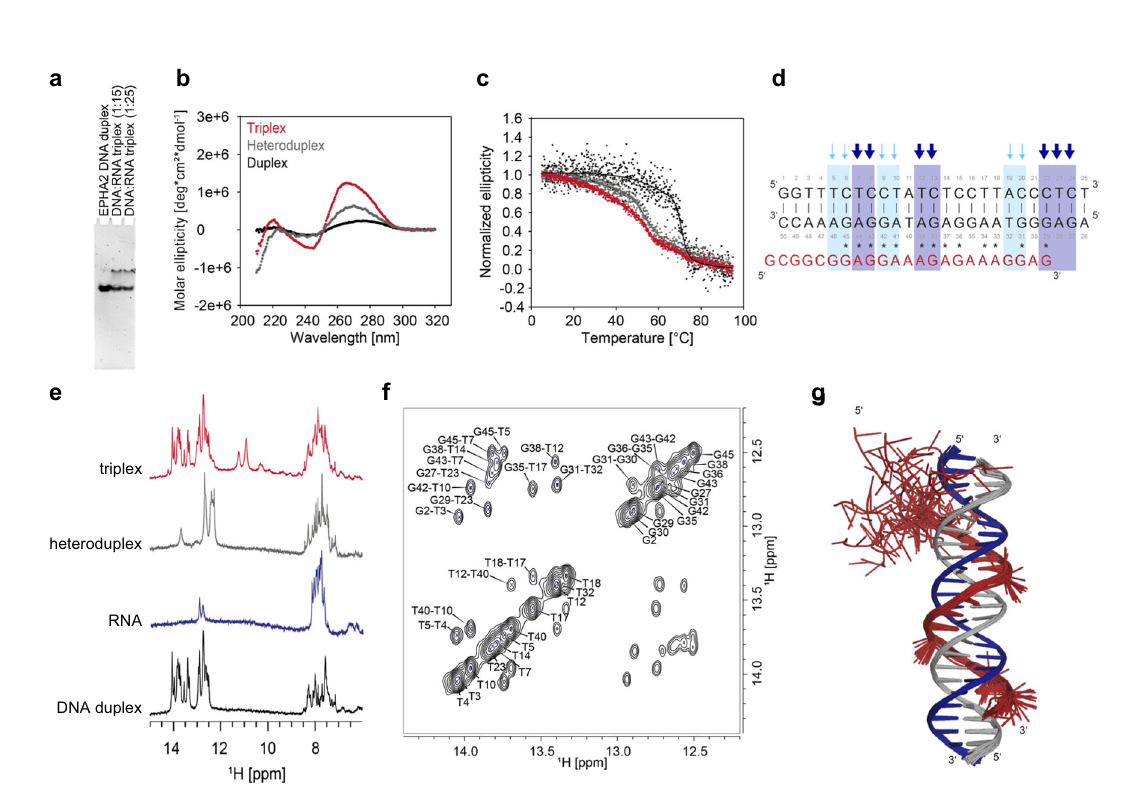
Fig. 2 | HIF1 α -AS1 potentially forms DNA:DNA:RNA triplexes. a Overview of the identi fi cation of HIF1 α -AS1 triplex forming regions (TFR) and their DNA triplex target sites (TTS) with triplex domain fi nder (TDF). HIF1 α -AS1 pre-RNA and ATAC- Seq of HUVECstreatedwith orwithout LNAGapmeRsagainst HIF1 α -AS1 wereused as input for TDF. RIP and LNA GapmeRs were used to validate the fi ndings of TDF. b All three TFRs of HIF1 α -AS1 have a signi fi cantly higher number of DNA triplex targetregions(bluedots)thantherandombackground(boxplotsingray).Boxplot visualizes the median, fi rst and third quartiles. The whiskers present the 1.5 inter- quartile range. External gray dots represent outliers. Numbers in brackets are positions of the individual TFR within HIF1 α -AS1 pre-RNA. Analyzed with TDF, n=200randomizations. c CircosplotshowingthelocalizationoftheindividualTFR within HIF1 α -AS1 pre-RNAanditsinteractionwiththechromosomalTTS. d Overlap of TTS of the individual TFRs of HIF1 α -AS1 . e Identi fi cation of RNase H-resistant TFRs. RIP with anti-S9.6 with/without RNase H treatment in HUVEC followed by qPCR for the TFRs. Ratio of %-input recovery with/without RNase H treatment is shown. n =8 independent experiments, paired t test. Dotted line represents